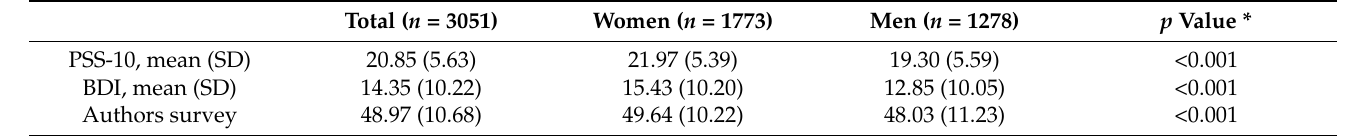
Table 3. Means (SDs) and statistical differences in the mental state between women and men.